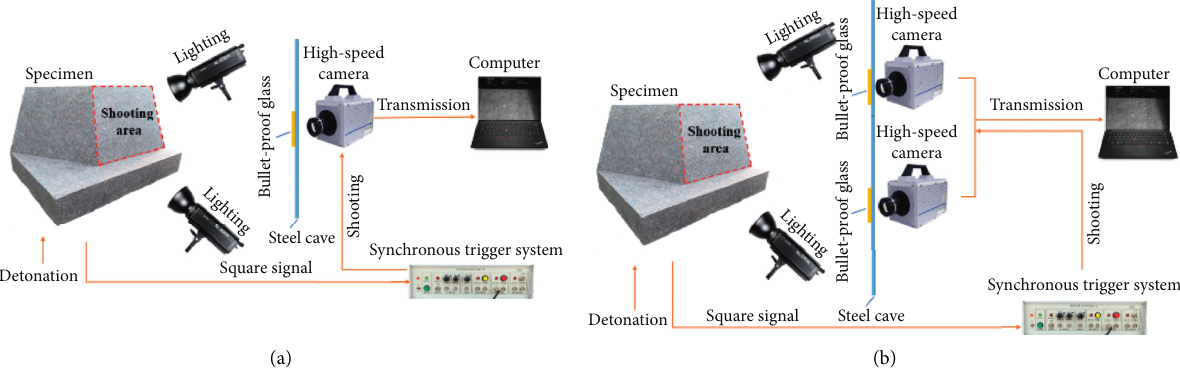
Figure 2: Schematic diagram of test systems: (a) test 1 (2D-DIC experimental system); (b) test 2 (3D-DIC experimental system).